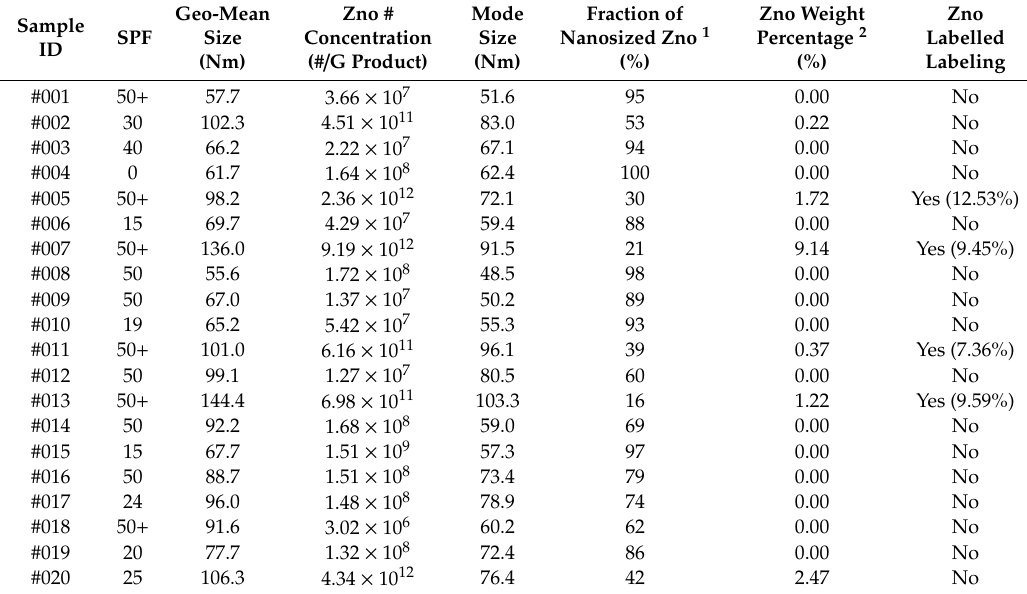
Table 2. Size, number, and weight concentration of ZnO in sunscreens by